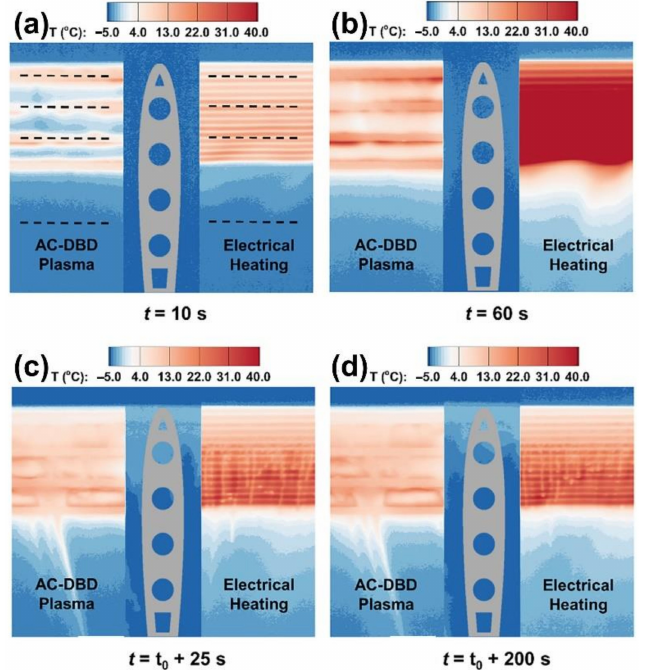
Figure 14. Time evolution of the temperature distributions over the DBD plasma actuator and the elec- trical film heater airfoil surfaces sides after: ( a ) t = 10 s, ( b ) t = 60 s, ( c ) t = t0 + 25 s, and ( d ) t = t0 + 200 s (adapted from Liu et al. [149] with the permission of Elsevier).